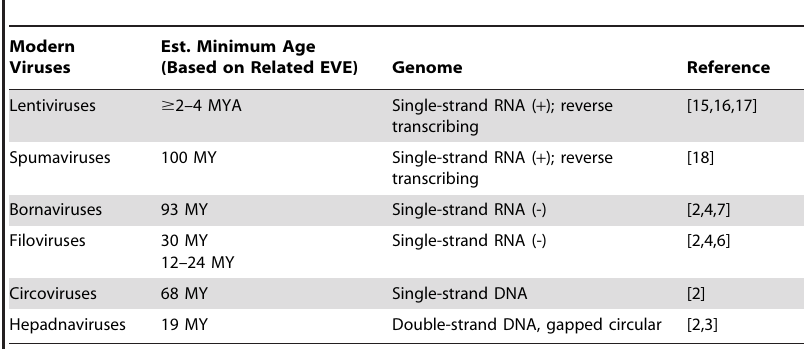
Table 1. Estimated Minimum Age of Select